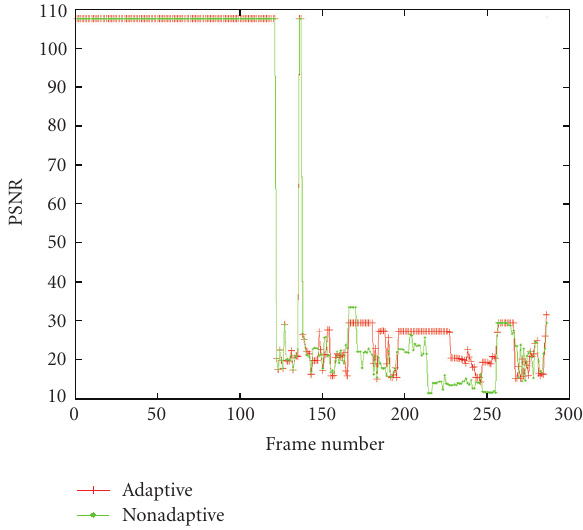
Figure 3: PSNR for “ foreman” sequence at 64kbps, random delay